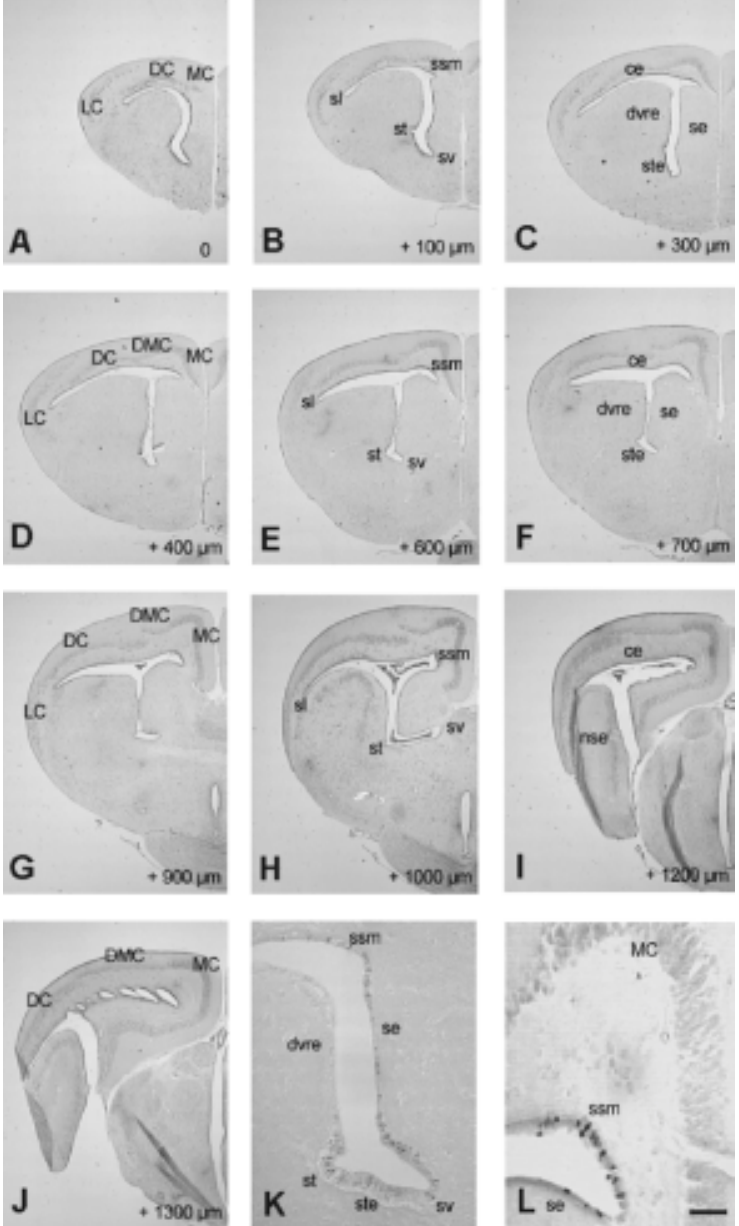
Fig. 4 –Transverse sections of the left hemisphere of Podarcis hispanica . A-J: Morphology of ten equidistant sections from rostral (A) tocaudal(J)levelsshowingthepositionofcorticalareas(MC:medialcortex; DMC:dorso-medialcortex; DC:dorsalcortex; LC:lateral cortex), ependymal sulci (ssm: sulcus septomedialis; sl: sulcus lateralis; st: sulcus terminalis; sv: sulcus ventralis) and intersulcal ependymal areas (ce: cortical ependyma; dvre: dorsal-ventricular ridge ependyma; ste: striatal ependyma; se: septal ependyma; nse: nucleus sphericus ependyma). K: enlarged aspect of the ependyma at the level of B showing the complex formed by the sulcus terminalis plus the sulcus ventralis and the striatal ependyma. L: enlarged aspect of the sulcus septomedialis at level G showing some PCNA labelled cells. (Scale bar represents 200 µ m in A-J and 30 µ m in K-L).